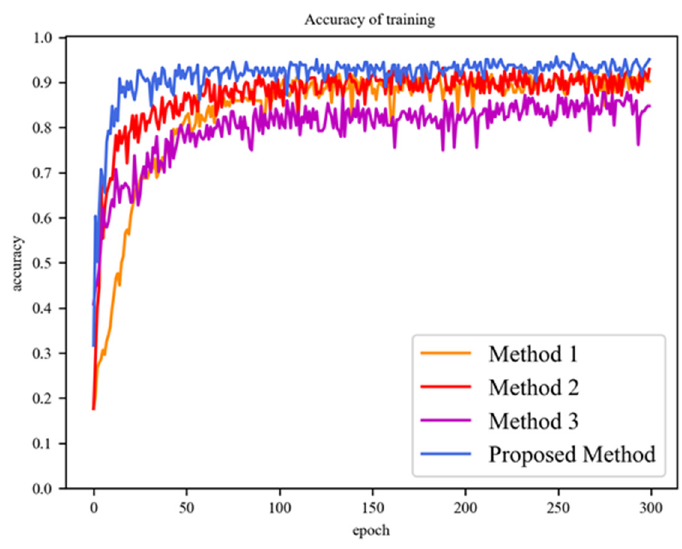
Figure 10. Accuracy of training for the four methods.